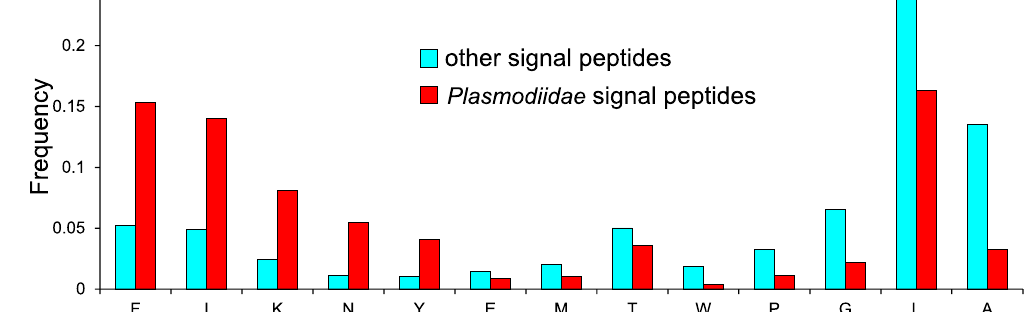
Figure 6. Mean frequency of amino acids that significantly discriminate SPs from Plasmodiidae and other organisms. Amino acids were arranged according to the difference in the mean